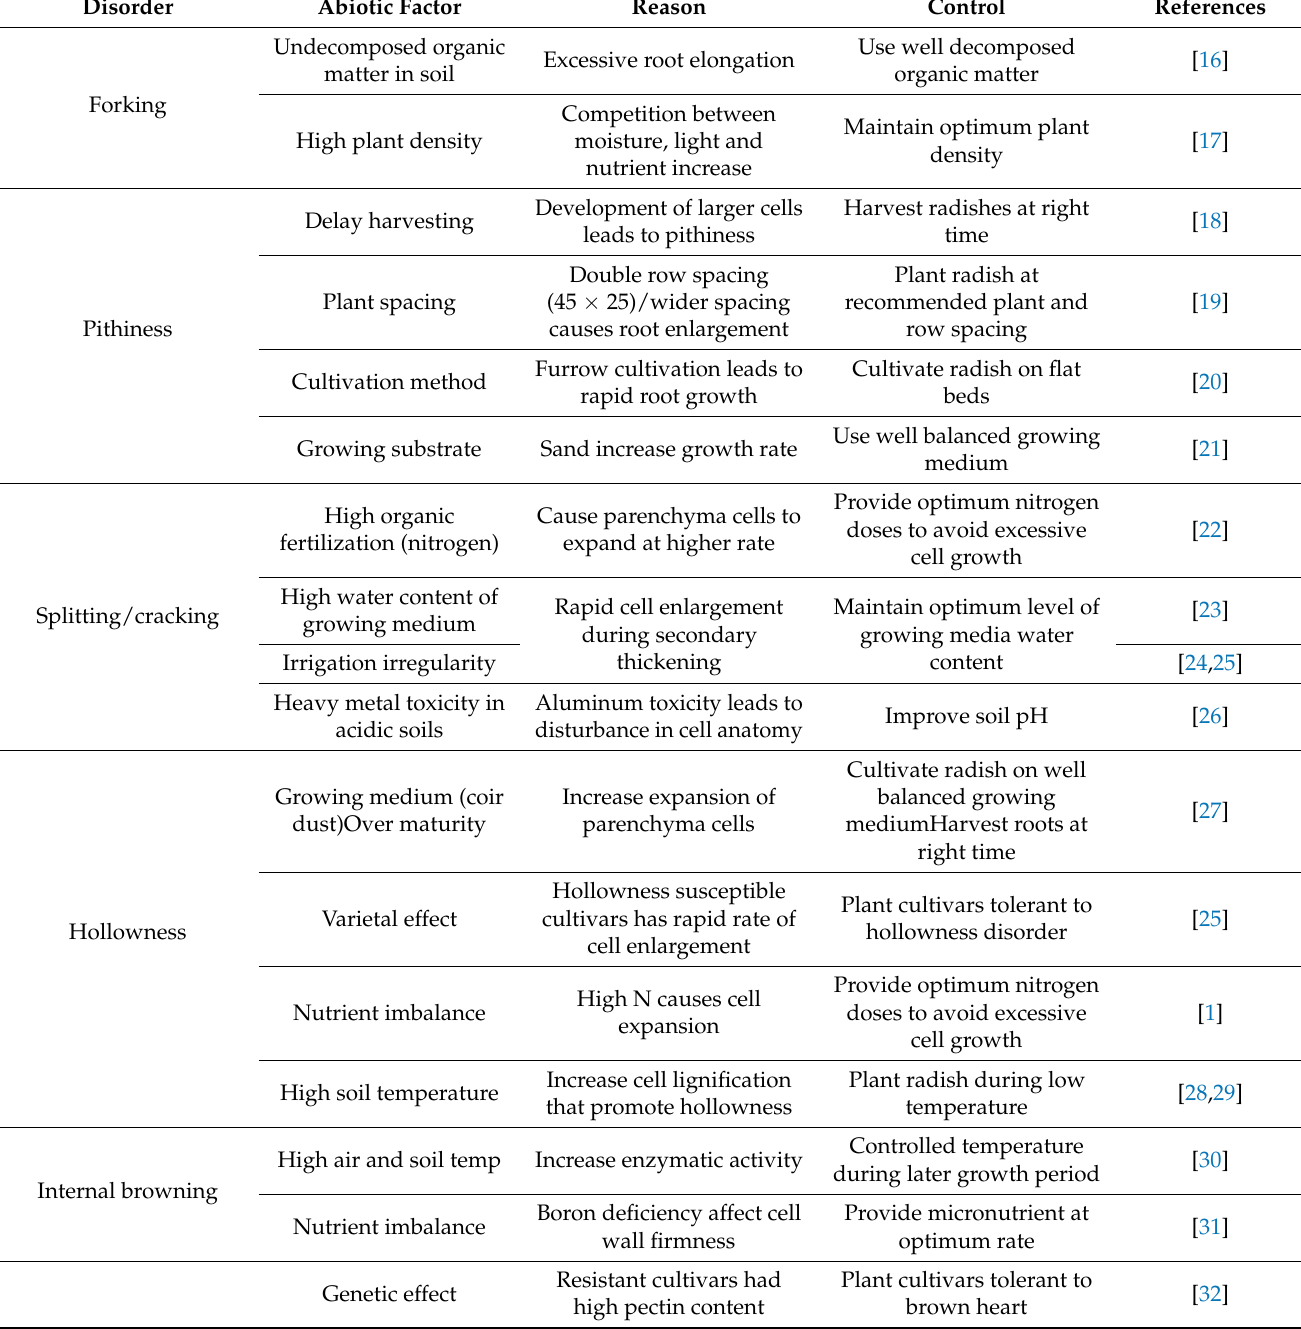
Table 1. Effect of different abiotic factors on incidence of physiological disorders in radish and their